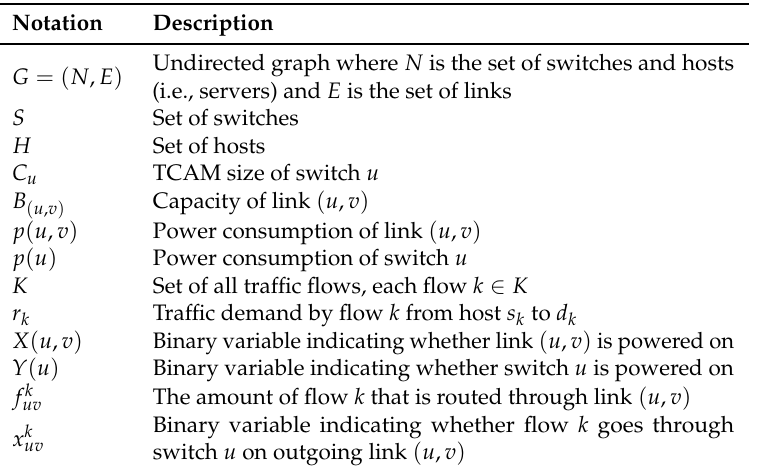
Table 2. Summary of notations.